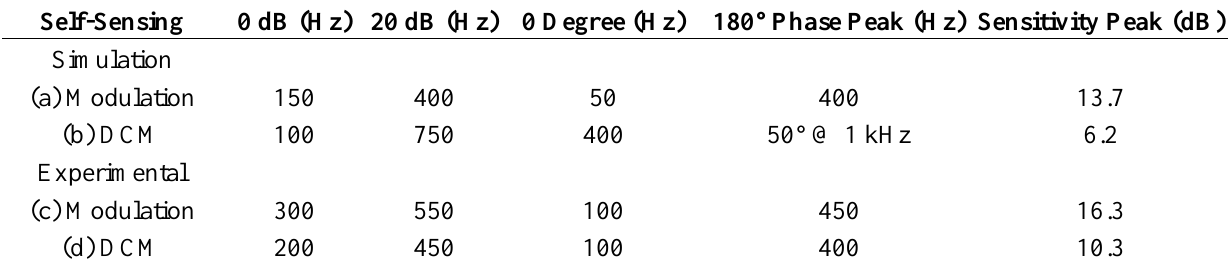
Table 2. Summary of self-sensing dynamic performance.